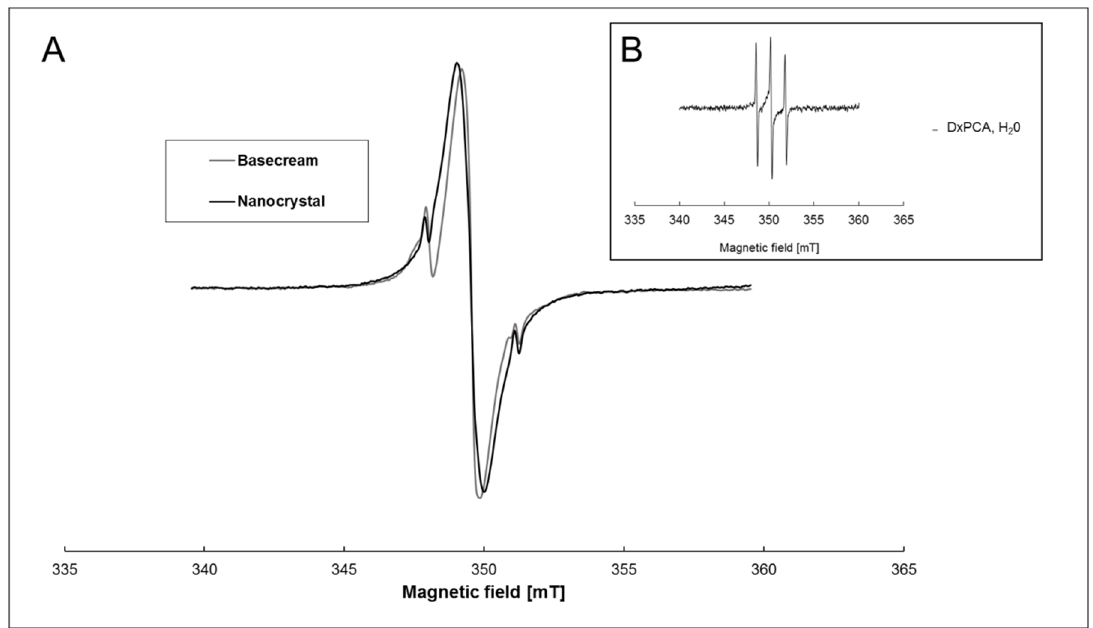
Figure 1. X-band electron paramagnetic resonance (EPR) spectra of dexamethasone–3-Carboxy-proxyl (DxPCA). ( A ) 1 mM of DxPCA dissolved in a base cream (grey line) and in a nanocrystal formulation (black line) at ambient temperature. Both spectra are normalized to the maximum height of the middle peak. ( B ) DxPCA (90 µM) dissolved in an aqueous solution [19].